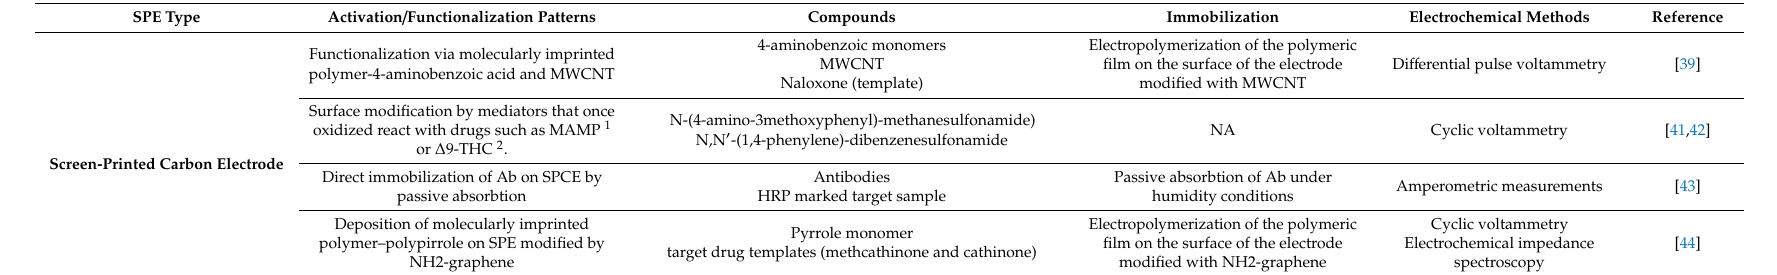
Table 2. Functionalization of various SPEs to detect illicit